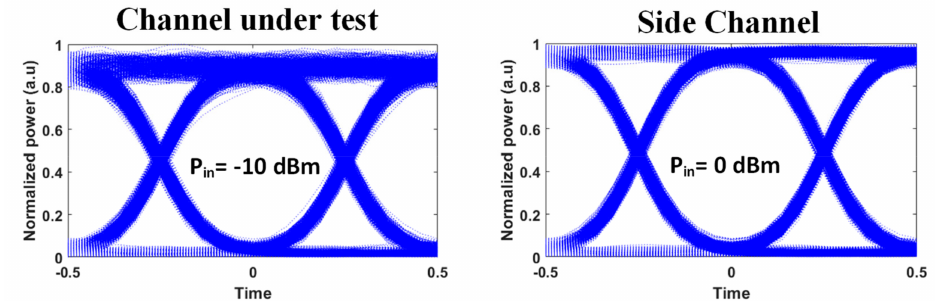
Figure 8. Simulated eye diagrams for the Ch.u.t. ( left ) and its 10 dB stronger side channel ( right ) for the case of input power of − 16 dBm and − 6 dBm respectively.